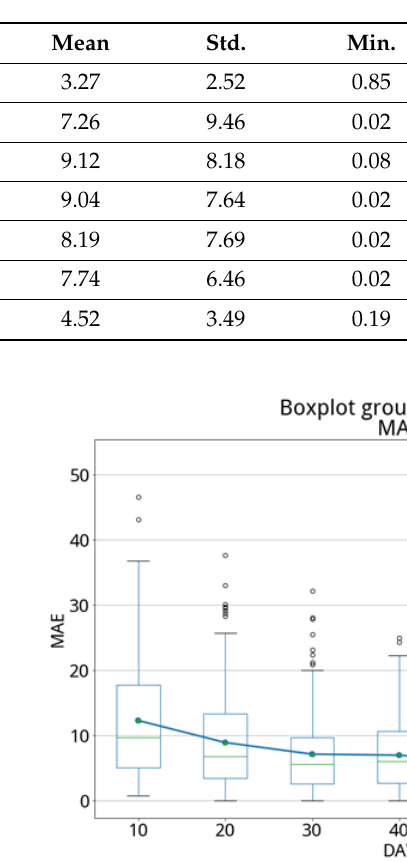
Table 8. Growth stage prediction results of cabbage from Day 0 to Day 70.